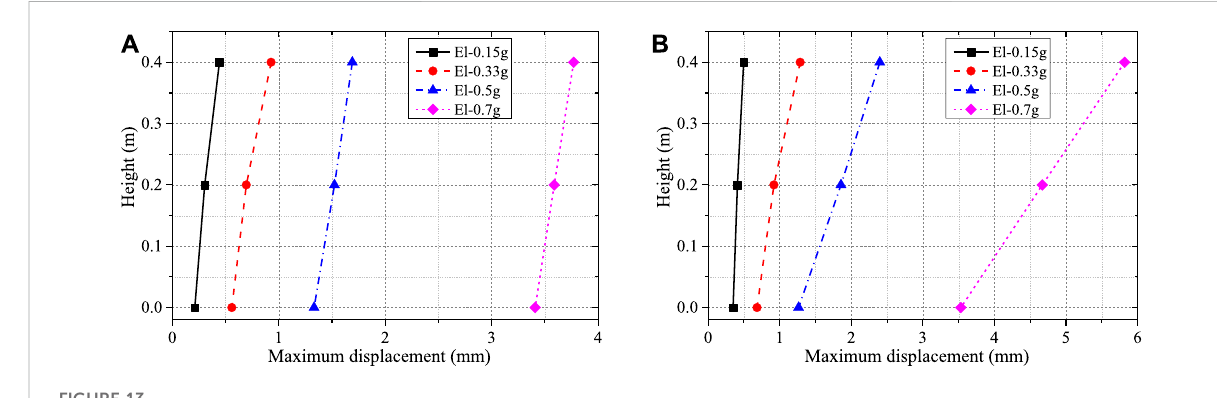
FIGURE 13 Maximum displacement distribution of disposal container 5# with different moisture content: (A) low moisture content; (B) high moisture content.